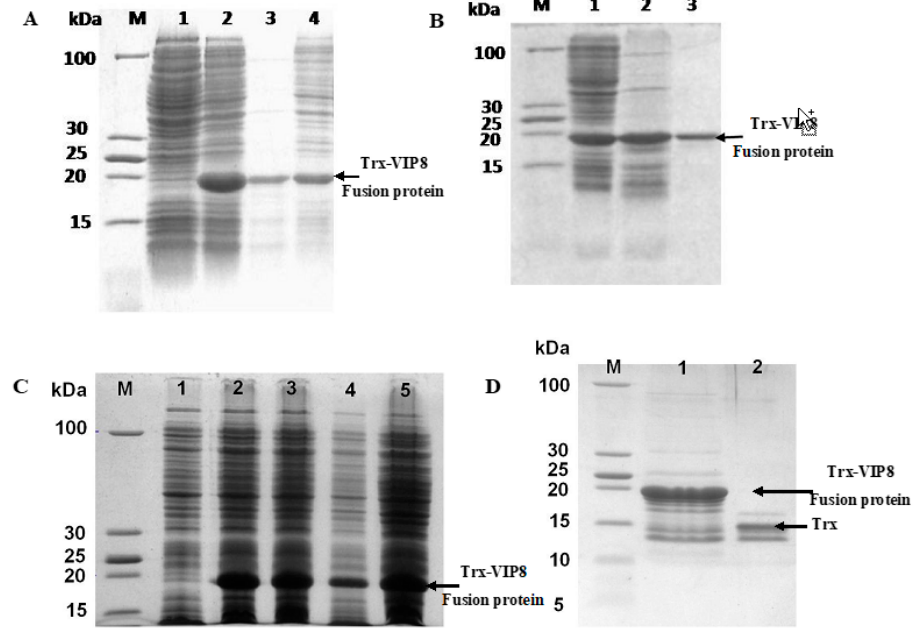
Figure 3. Expression, purification and identification of recombinant VIP analogue 8. ( A ) Expression of pET32a-VIP8 fusion protein analysed by SDS-PAGE. lane M: protein molecular mass marker; lane